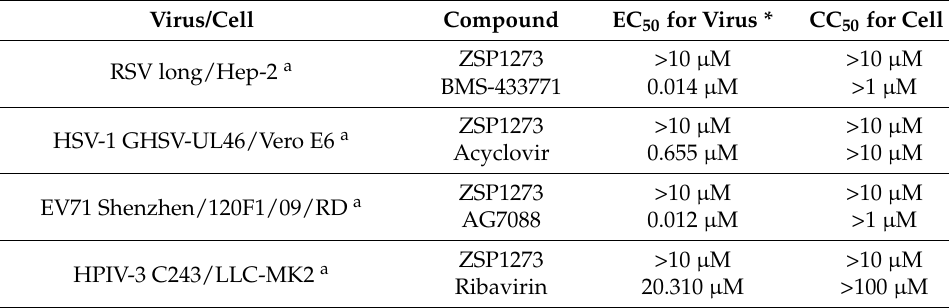
Table 3. Assay results of ZSP1273 against different viruses.